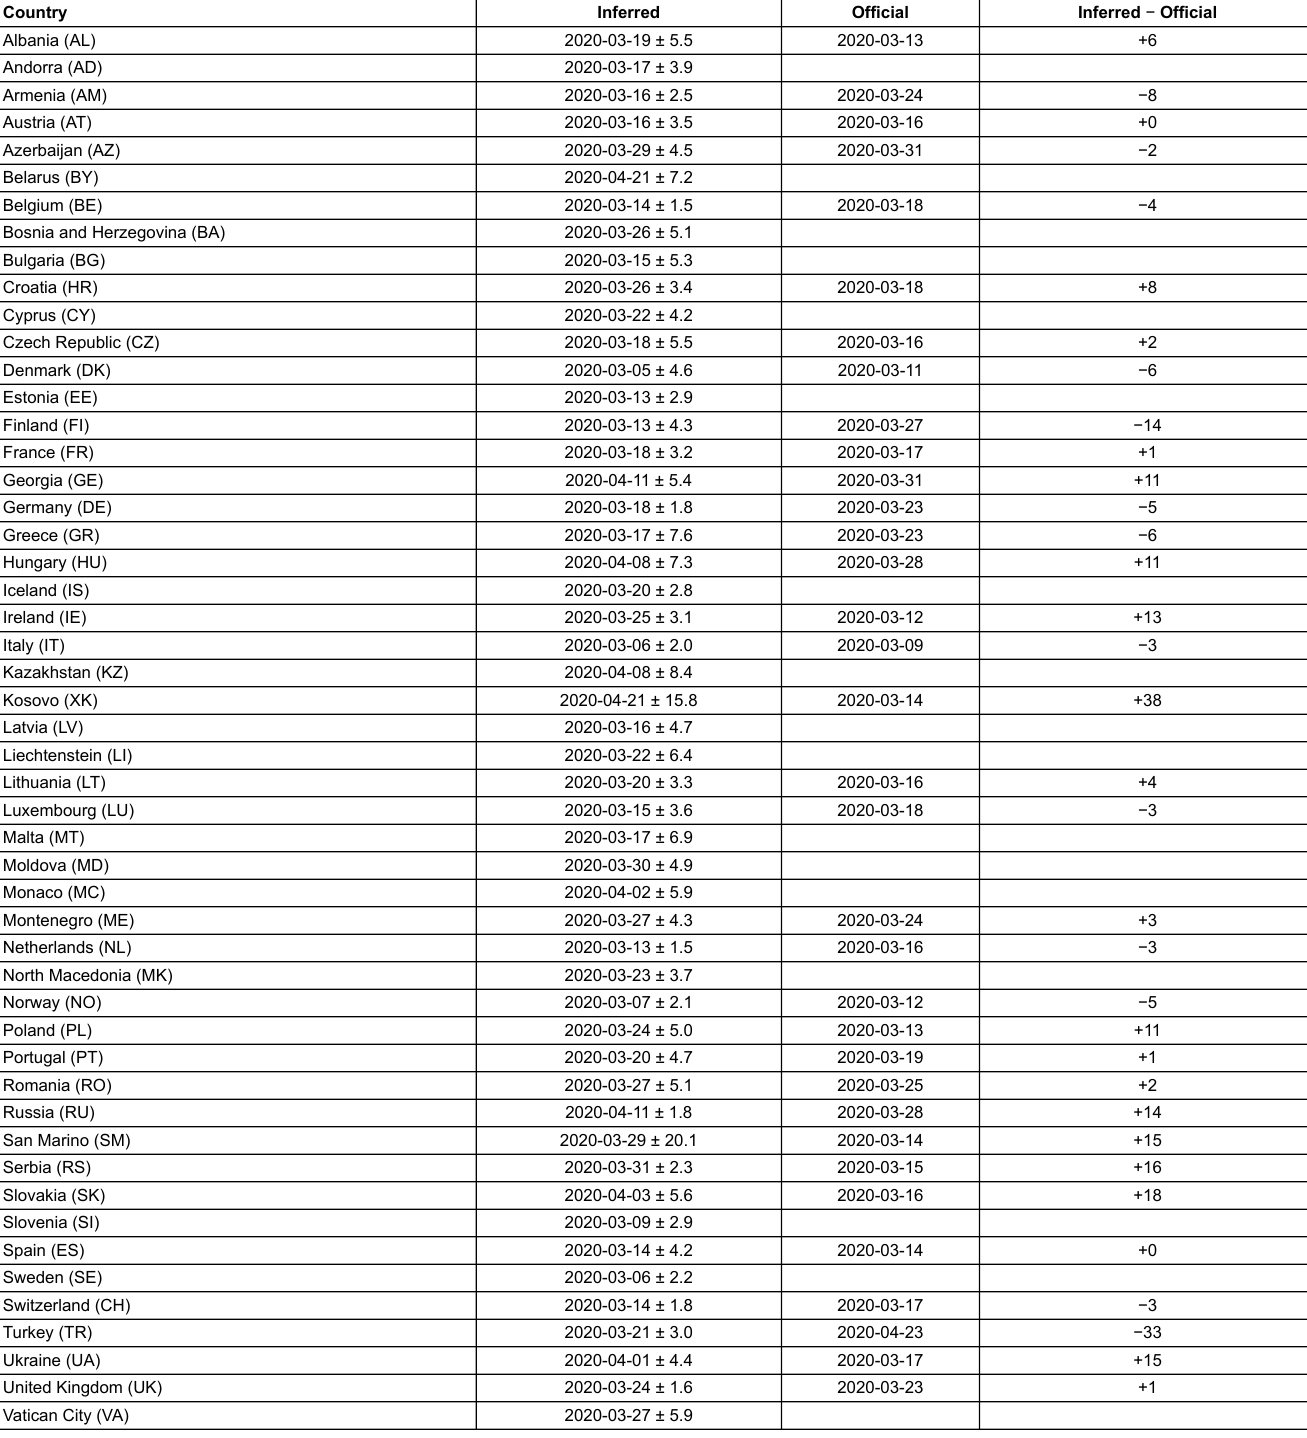
Table 2: Inferred time of the start of interventions t int − ½ δ int (mean and standard deviation) compared to the official beginning of non-pharmaceutical interventions [15] in each country. Country Inferred